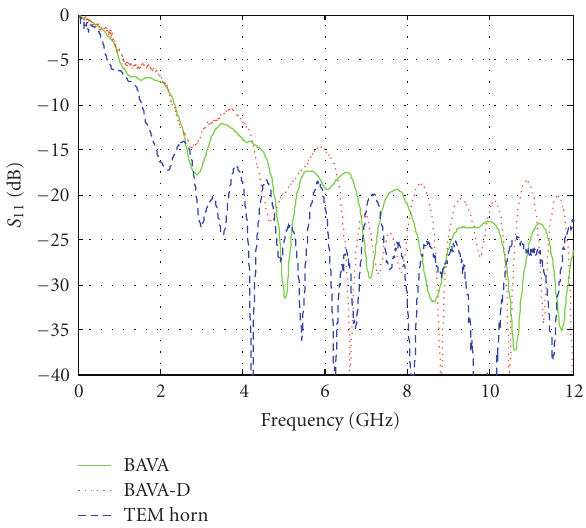
Figure 8: Measured S 11 for all 3 antennas.